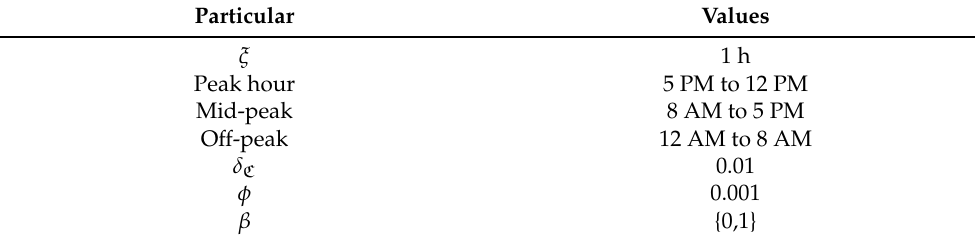
Table 2. Simulation